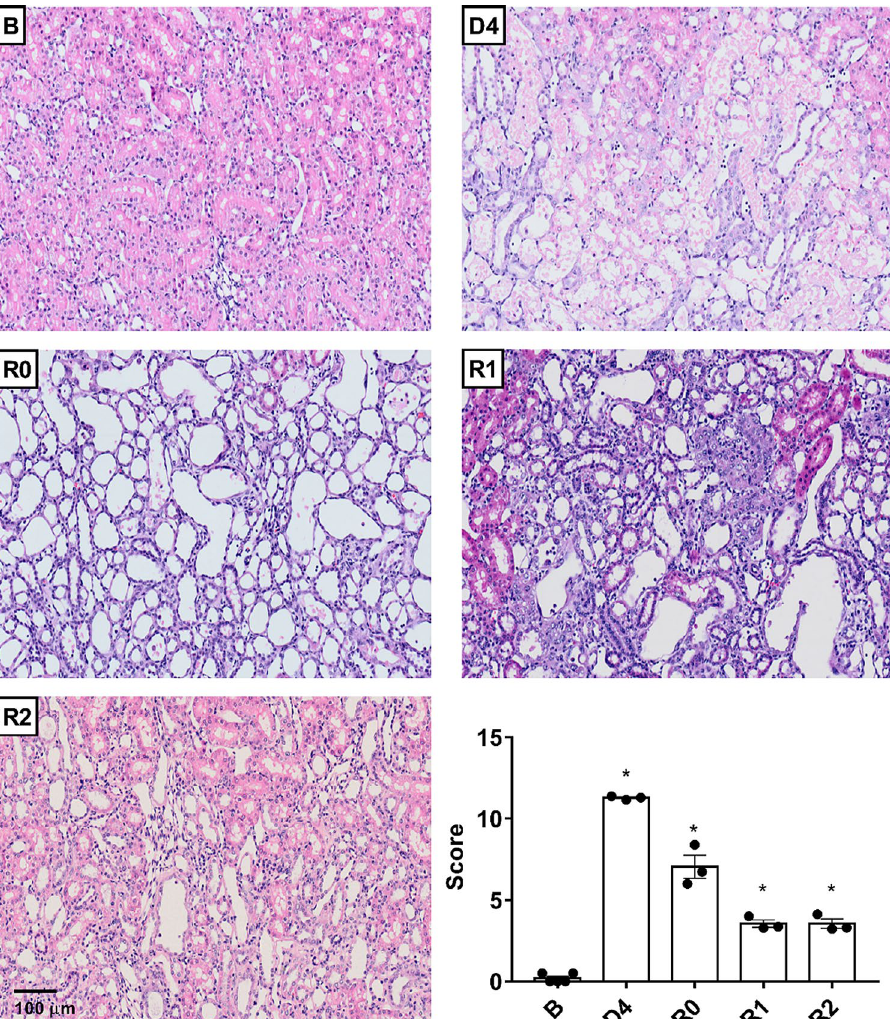
Figure 2. Renal histology: histological damage. Hematoxylin–eosin staining in control group, D4, R0, R1 and R2; quantification of histological damage (score). P < 0.01: * versus